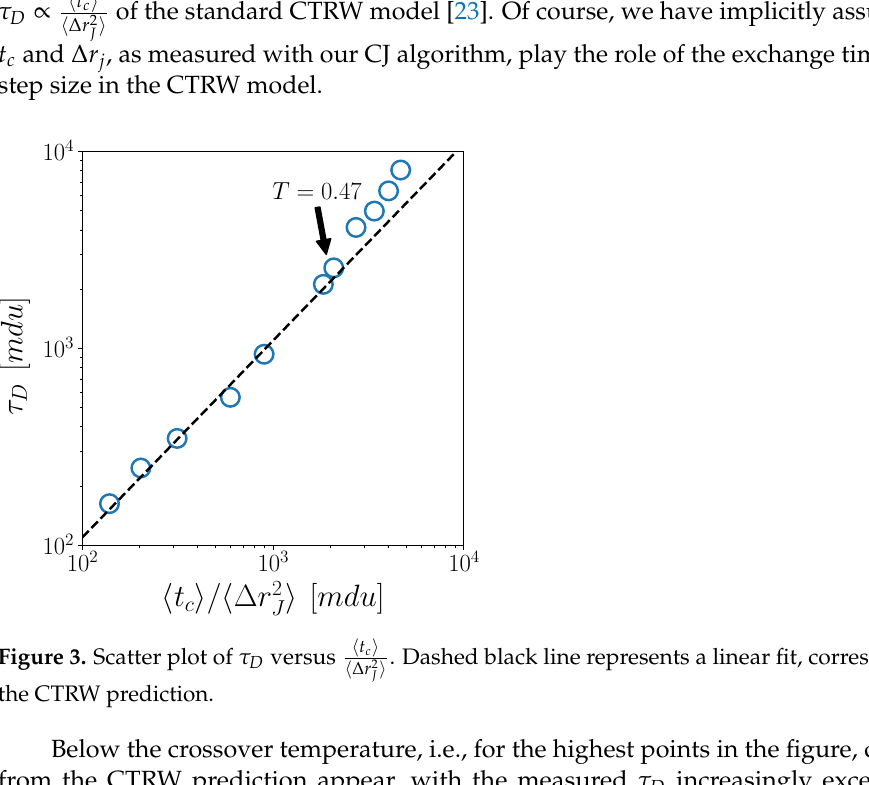
lattice models. We plot in Figure 3 τ D vs. (cid:104) t c (cid:105) of the data is well captured by a linear fit (dashed line), which agrees with the prediction τ D ∝ (cid:104) t c (cid:105)